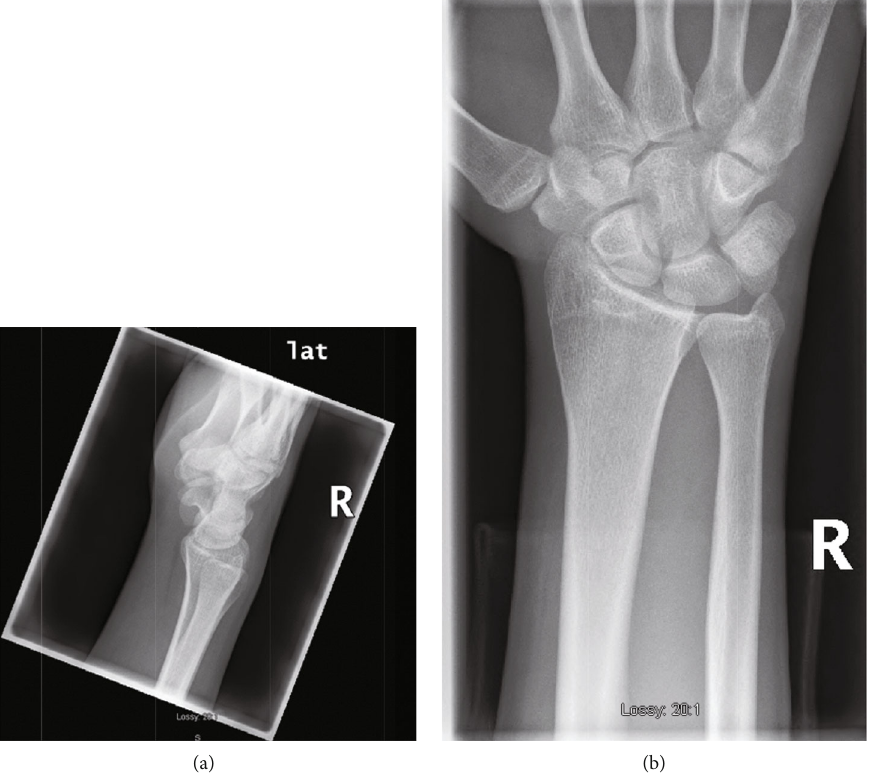
Figure 1: (a, b) X-ray right wrist PA and lateral views suggestive of a dual hamate